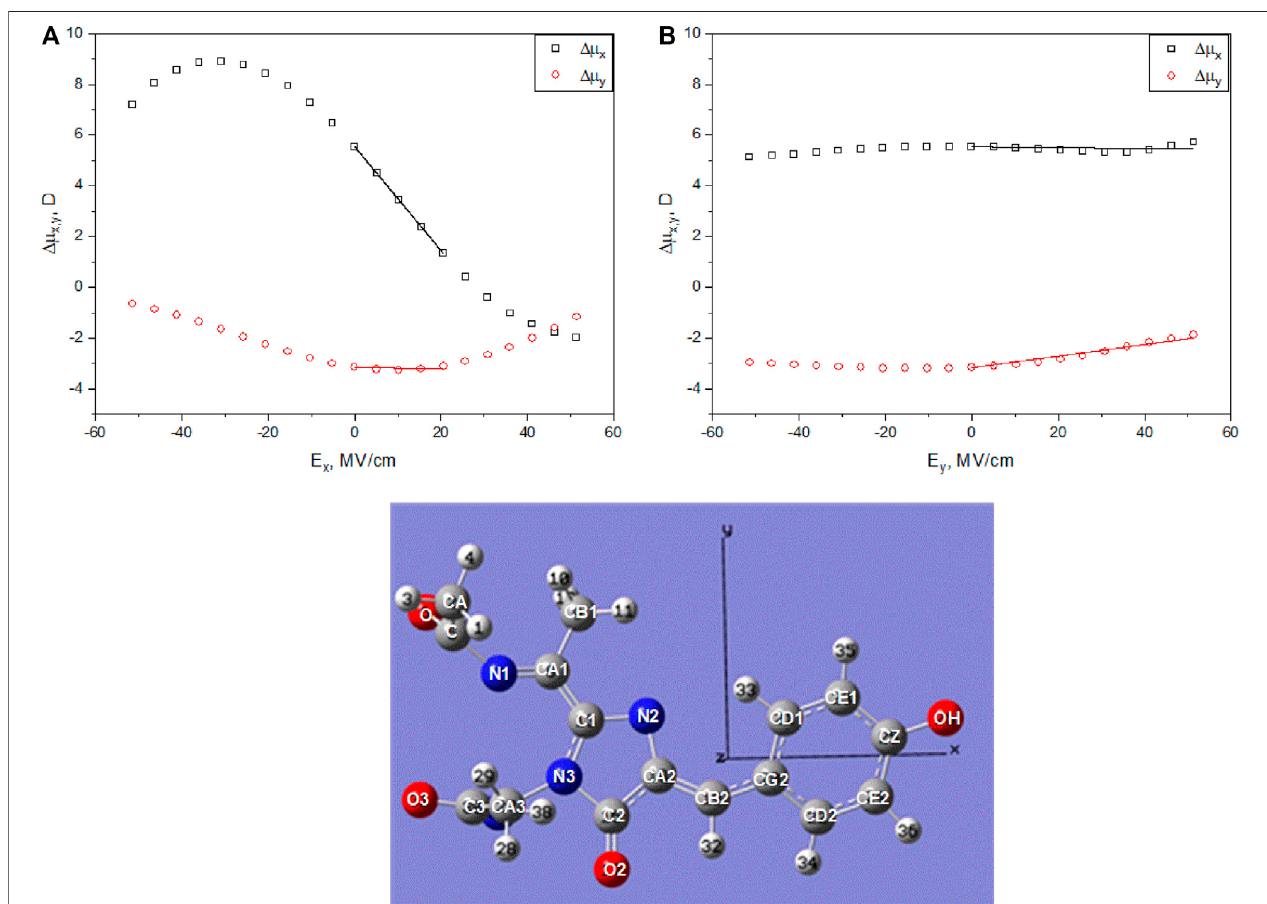
FIGURE 4 | Top: Calculated permanent dipole moment differences, Δ μ x (black squares) and Δ μ y (red circles), between the excited and ground states of the RFP chromophore as function of applied electric fi eld E x (A) and E y (B) . In the calculations, the chromophore structure was optimized for each value of the fi eld with the phenolate and imidazolinone rings constrained to lie in the same plane ( fl at chromophore). Bottom: Chromophore structure optimized at zero fi eld with the directions of axes x and y shown.